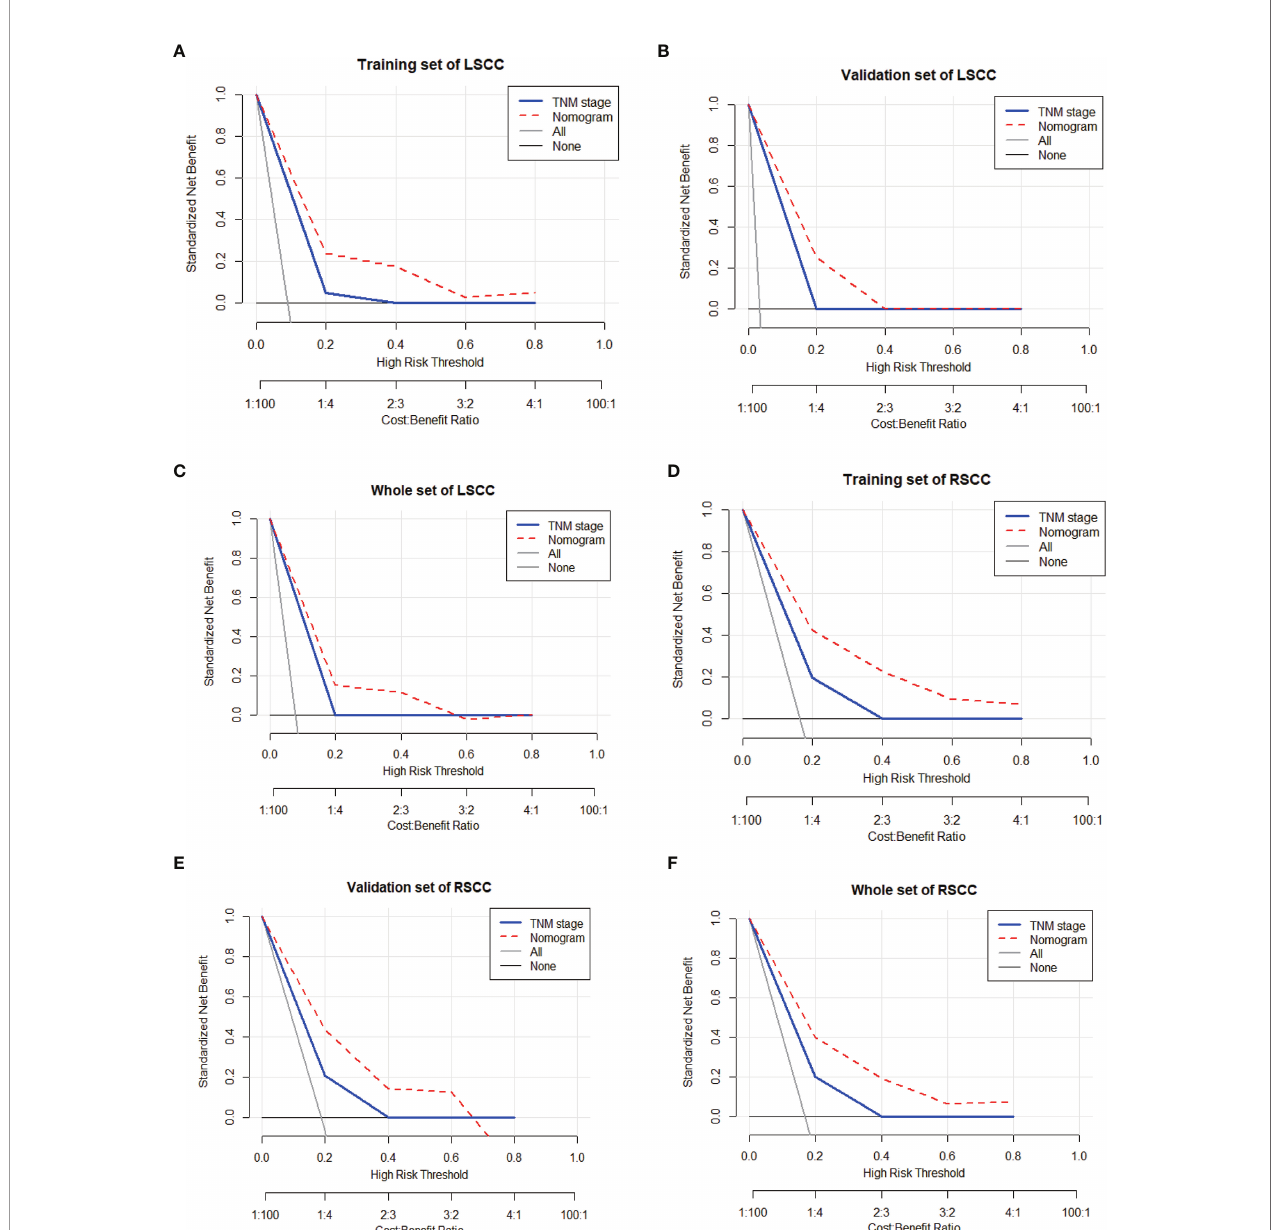
FIGURE 4 | Decision curve analysis (DCA) to assess the clinical usefulness of the nomogram and TNM stage in the training set (A) , validation set (B) , and whole set of LSCC (C) . And DCA in the training set (D) , validation set (E) , and whole set of RSCC (F) .